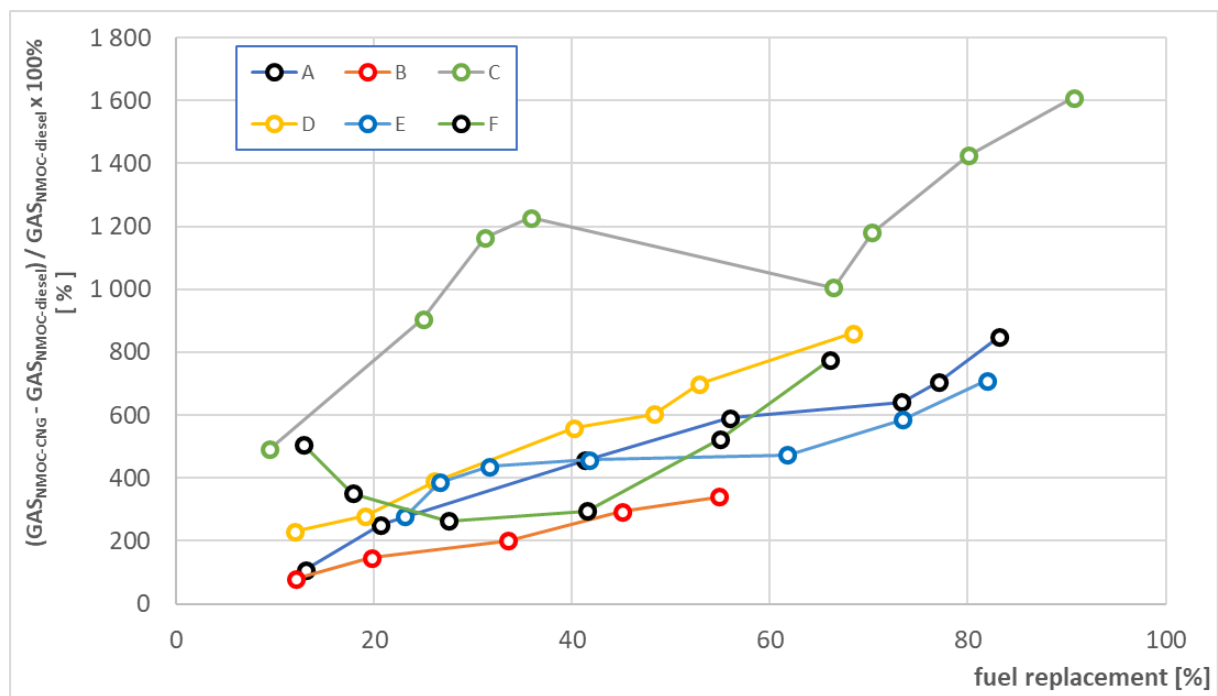
Figure 16. Curves from A to F showing the changes in the emission of NMOC as the comparison of exhaust gas temperature noted only in single fuel (diesel) working mode for individual engine operating points, where the rotation speed, power, and torque were constant, as a dual-fuel mode (where engine uses CNG and diesel fuel) replacement function.